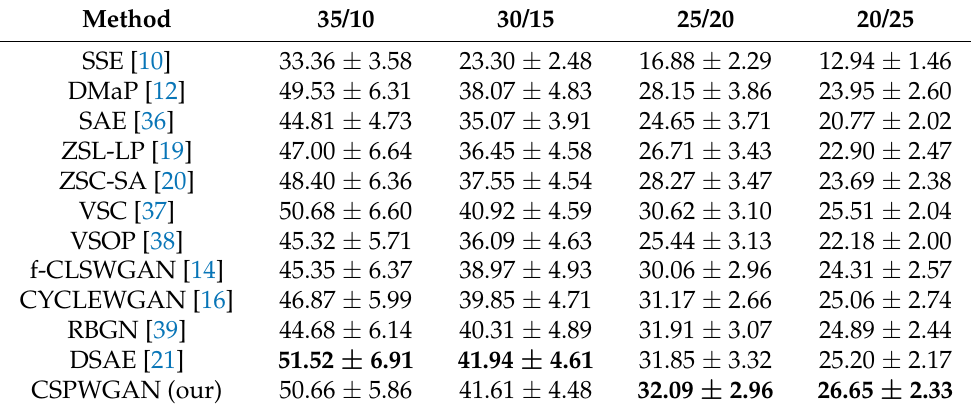
Table 4. With different seen/unseen ratios, the average ZSL classification accuracies and standard deviation (%) of our CSPWGAN model and the sota methods on the NWPU45 dataset. Bold font denotes the best